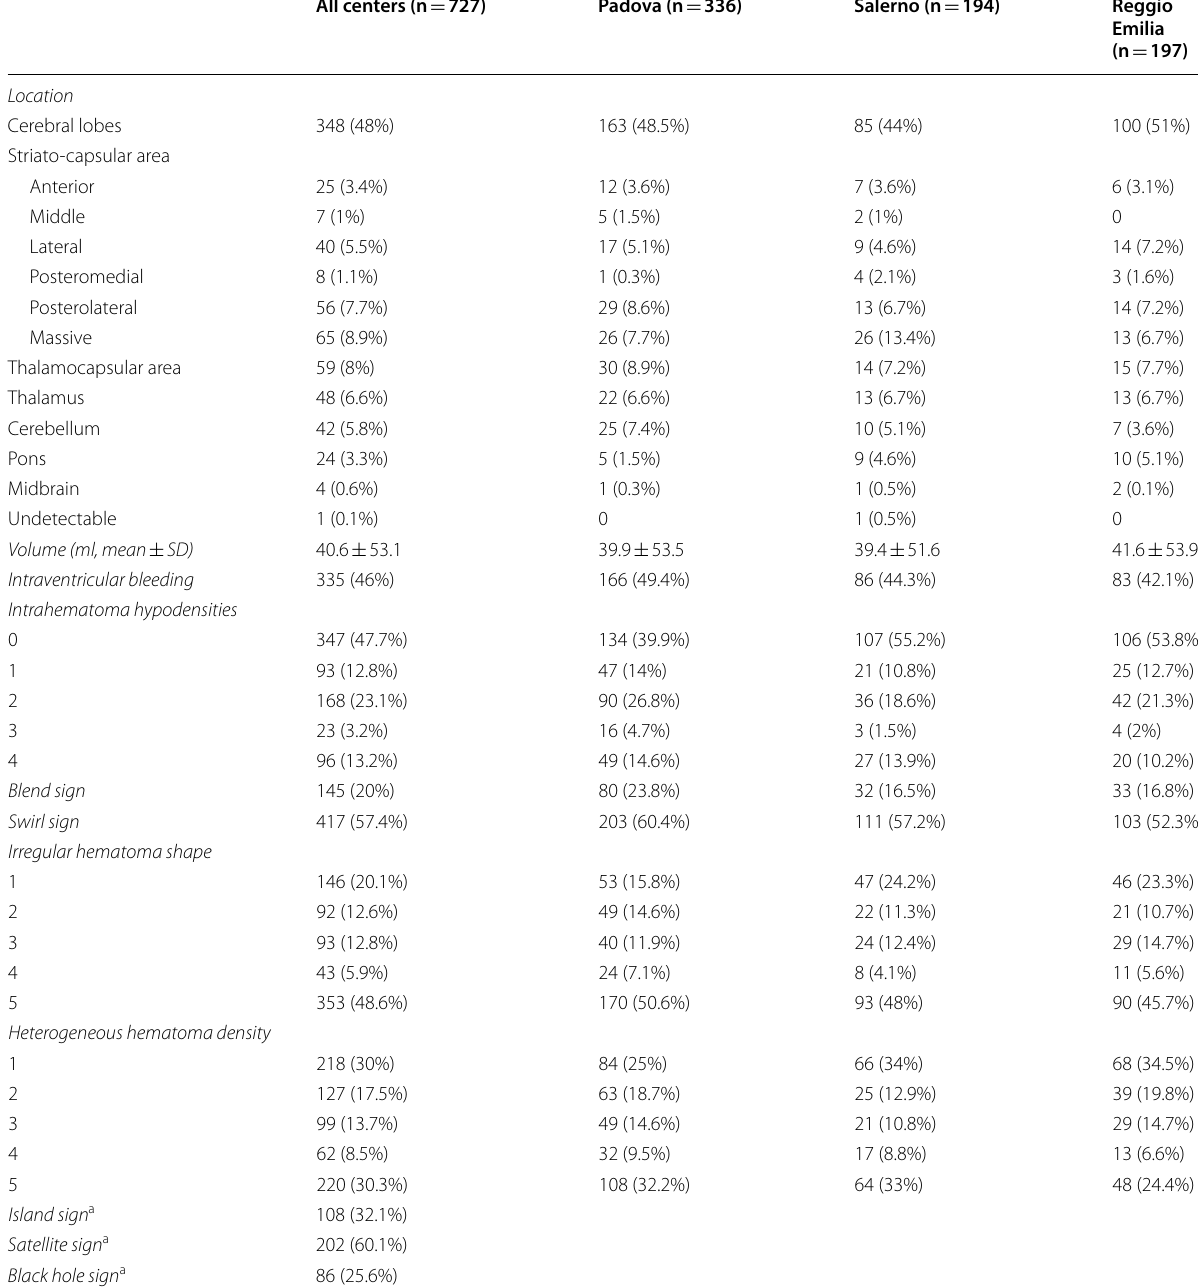
Table 1 Baseline radiological cohort